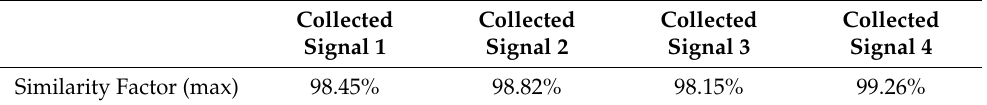
Table 4. Similarity factor (max) between the separated signals and the Collected Signals